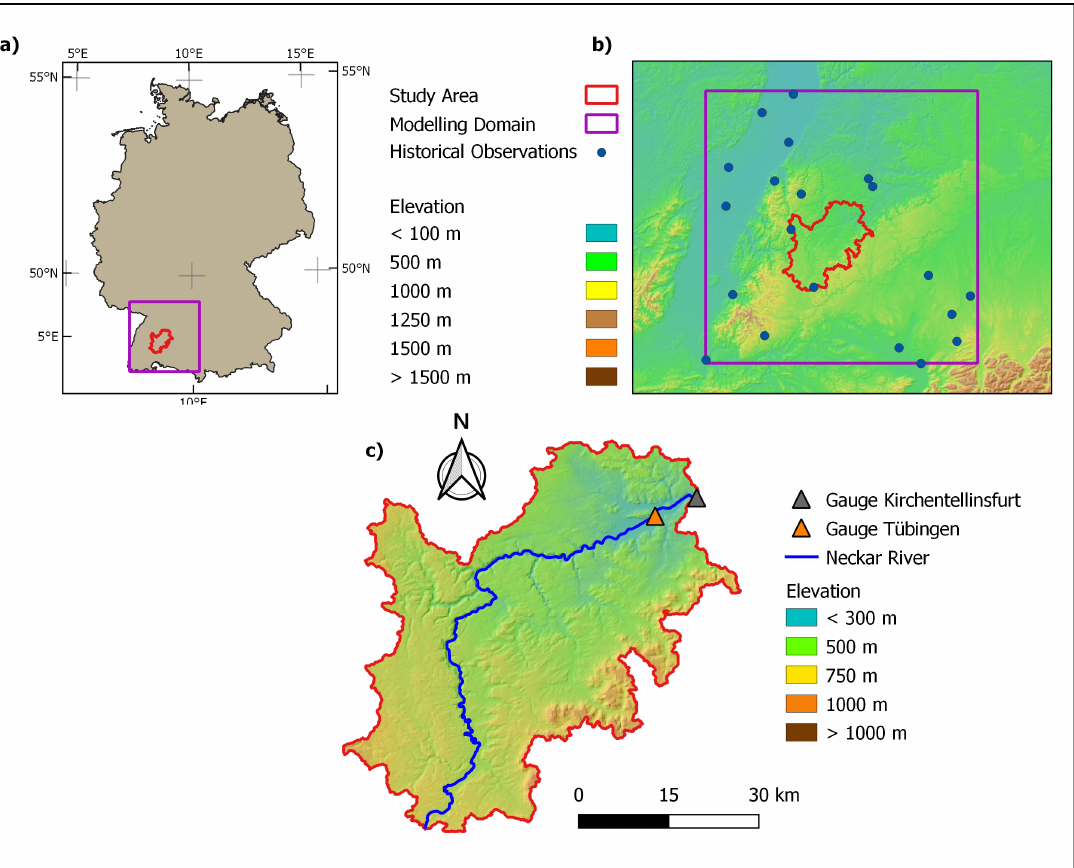
Figure 1. Maps showing ( a ) the location of the study area in Germany, ( b ) the modelling domain with the sites of the historical precipitation gauges and ( c ) the catchment area of the gauge at